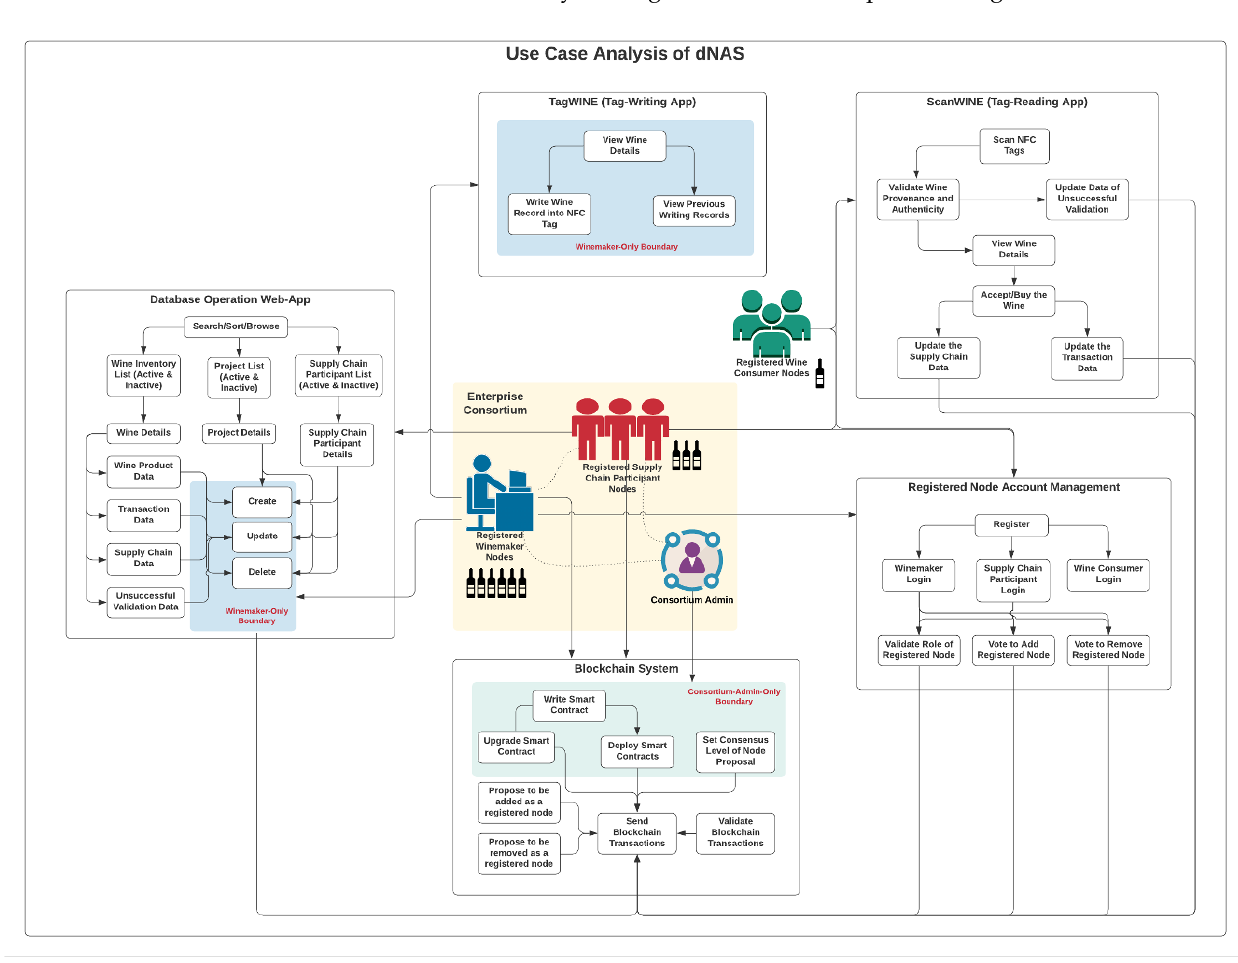
Figure A2. Use Case Analysis Diagram of